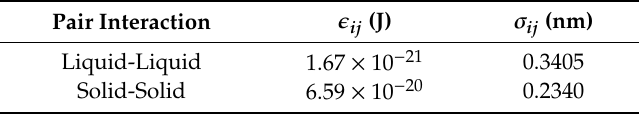
Table 1. Lennard-Jones interaction